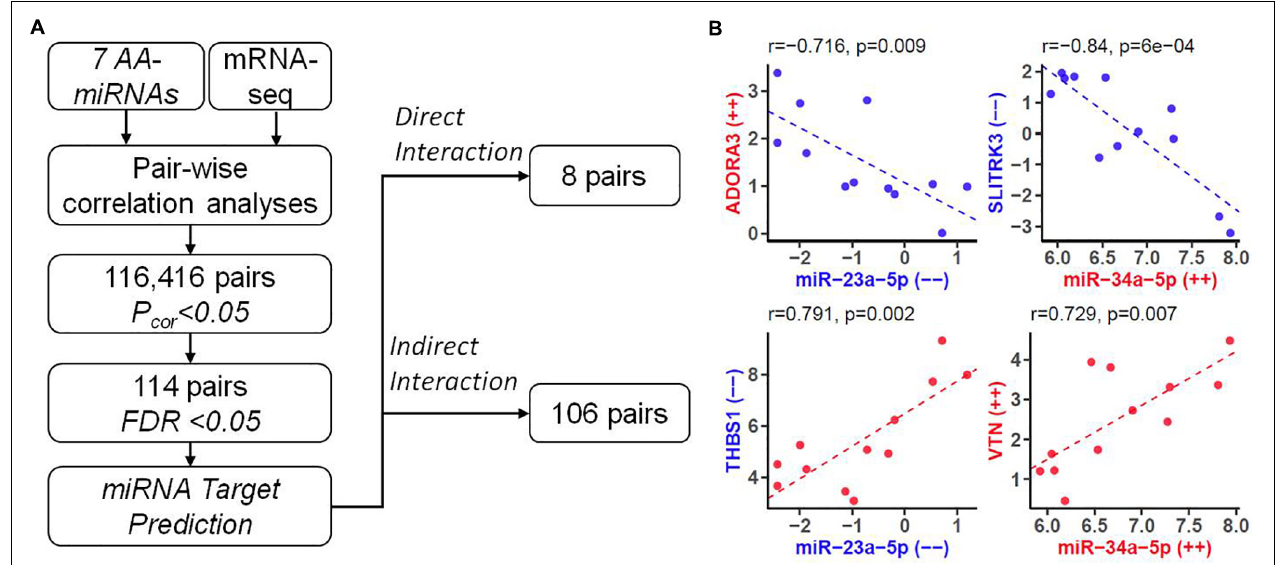
FIGURE 4 | Identifying downstream genes of AA-associated miRNAs. (A) Flowchart of predicting miRNA-mRNA pairs for human AA by integrating mRNA-seq data with bioinformatics analysis. FDR, false discovery rate. (B) Four types of miRNA-mRNA interactions. In each plot, X-axis represented expression levels (count per million at log2 scale) of a miRNA, and Y-axis represented expression levels of a gene. Labels with “–” or “++” indicated decreased or increased expression in older group compared to younger group. Such effect size were also highlighted by color (color, down-regulation; red, up-regulation). Pearson Correlation coefficient ( r ) and the corresponding P value were shown at the top.